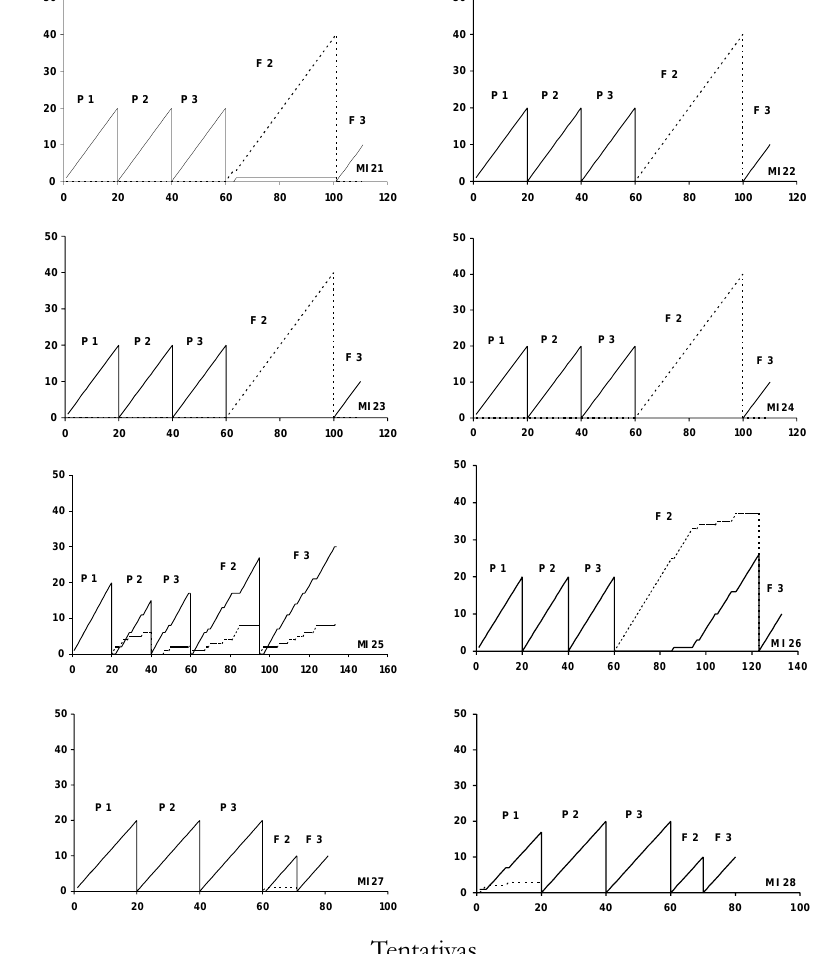
Figura 2. Freq(cid:252)Œncia acumulada de respostas nªo verbais corretas (linha s(cid:243)lida) e incorretas (linha tracejada ), para cada participante (MI) da Condi(cid:231)ªo ’Mœltiplas Instru(cid:231)ıes’, durante cada passo (P) da Fase 1 e nas Fases 2 e 3. Quebras na curva acumulada indicam mudan(cid:231)as de passo e de fase (F). Na Fase 1, as instru(cid:231)ıes dos Passos 1, 2 e 3 correspondiam (cid:224)s contingŒncias e variavam entre os passos. As contingŒncias em vigor no Passo 3 eram revertidas na Fase 2, tornando as instru(cid:231)ıes do Passo 3 discrepantes, e restabelecidas na Fase 3. emitindo respostas corretas, ora emitindo respostas incorretas. contingŒncias e passaram a responder corretamente, de acordo No Passo 3, seguiu as instru(cid:231)ıes apresentadas no in(cid:237)cio do com as contingŒncias em vigor na Fase 2. Os Participantes passo, emitindo trŒs respostas incorretas durante o passo, na MI25 e MI26 iniciaram a Fase 2 seguindo as instru(cid:231)ıes 7“, 10“ e 20“ tentativas. apresentadas no in(cid:237)cio do Passo 3. Depois, o Participante MI25 Na Fase 2, quando as contingŒncias foram mudadas e essa passou a responder corretamente nas 6 tentativas que se seguiram mudan(cid:231)a foi sinalizada, o comportamento nªo-verbal de 4 (cid:224) inicial. Da 8“ a 25“ tentativa variou seu desempenho, apresentando participantes (MI21, MI22, MI23 e MI24) permaneceu inalterado. Isto Ø, o comportamento nªo-verbal dos Participantes MI21, MI22, MI23 e MI24 nªo mudou acompanhando a mudan(cid:231)a nas contingŒncias. Estes participantes continuaram emitindo as mesmas respostas nªo-verbais que haviam emitido no Passo 3. Assim, programadas na Fase 2, e atingiu o critØrio de 10 respostas seus desempenhos tornaram-se incorretos. Em contraste, os consecutivas corretas para o encerramento desta fase. JÆ o Participantes MI25, MI26, MI27 e MI28 mudaram seus Participante MI26 continuou seguindo as instru(cid:231)ıes atØ a 25“ desempenhos nªo-verbais acompanhando a mudan(cid:231)a nas tentativa. Na 26“ tentativa respondeu corretamente, mas voltou Psicologia: Reflexªo e Cr(cid:237)tica, 2004, 17(3),